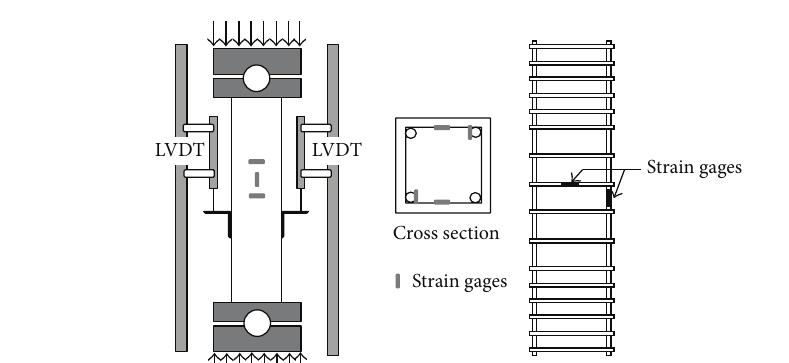
Figure 2: Schematic of the compression test